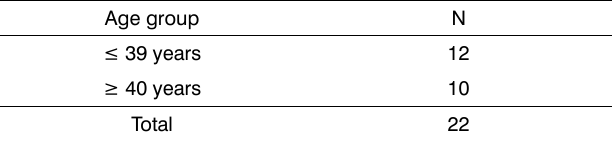
Table 2. Division of subjects into two age